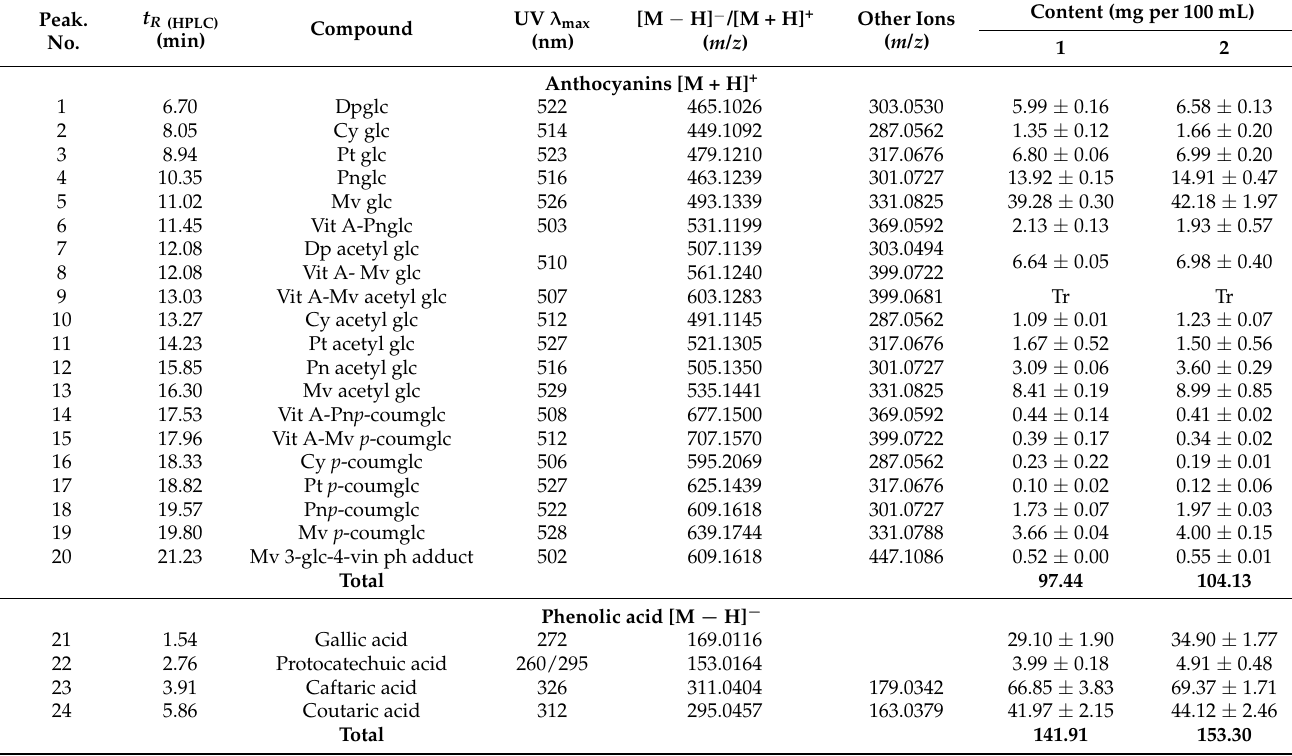
Table 2. Identification and the content (mg/100 mL) of anthocyanins and phenolic acids of red wine (1) and PC concentrate (2) by UPLC-ESI-qTOF-MS/MS) and HPLC-PDA. Peak.